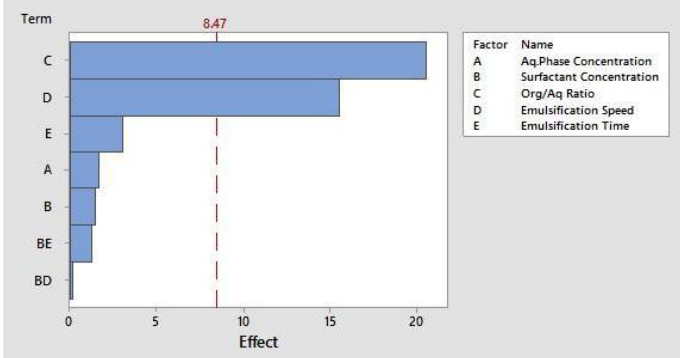
FIG. 1. PARETO CHART OF EFFECTS FOR STABILITY AS RESPONSE